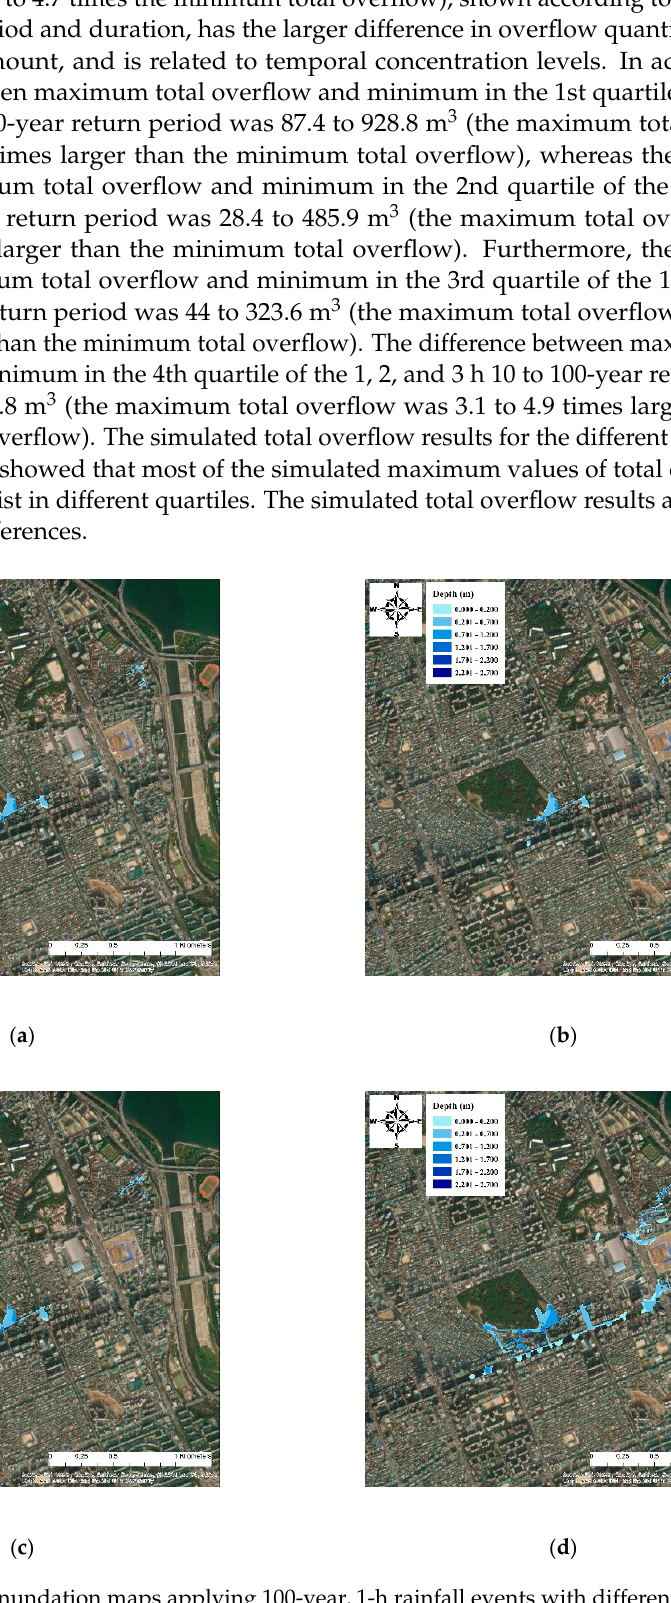
Figure 9. Sample inundation maps applying 100-year, 1-h rainfall events with different exceedance probabilities (( a–d ): 10%, 30%, 60%, 90%) of Huff 4th quartile